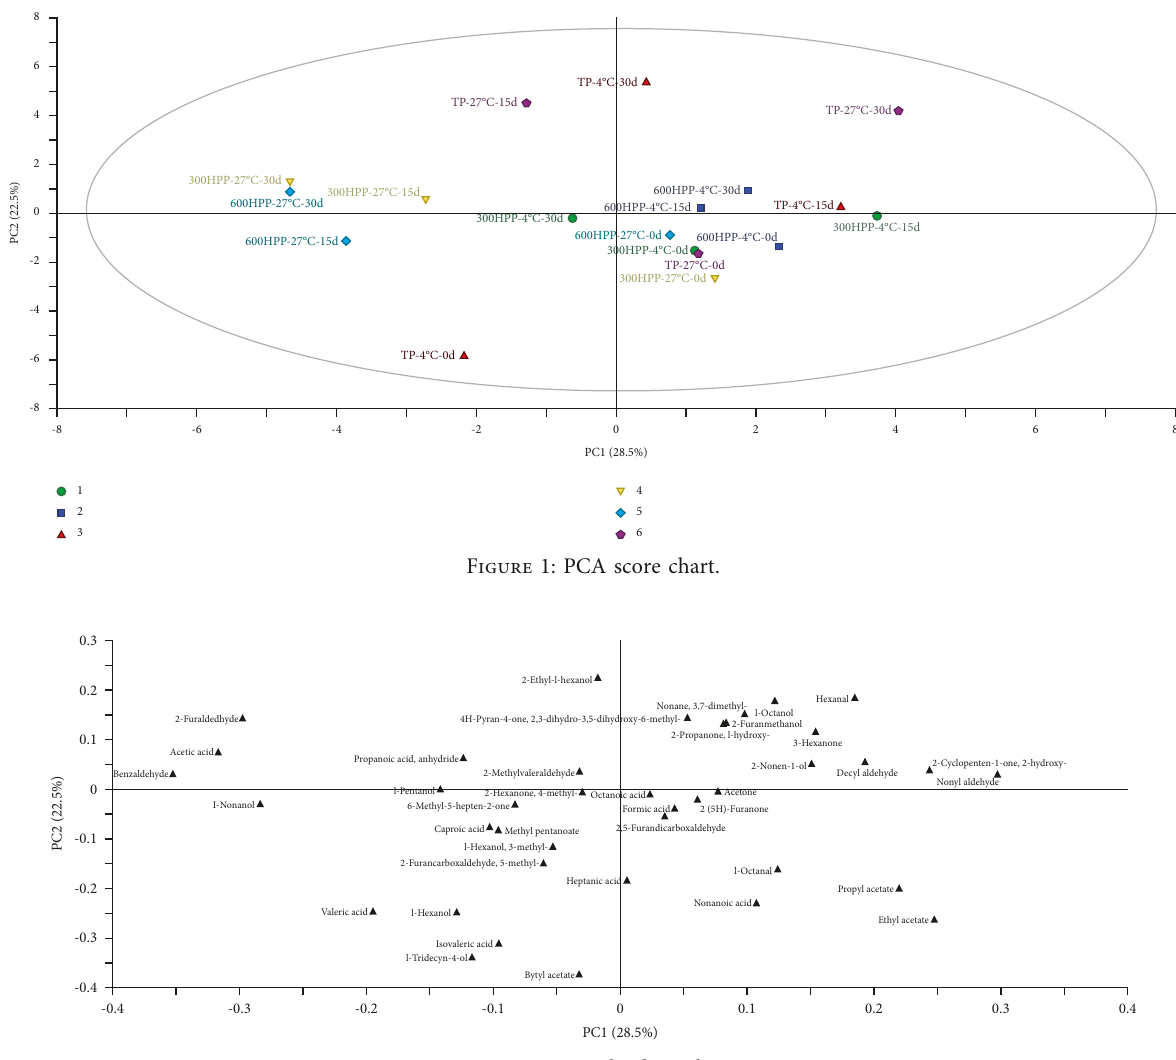
Figure 2: PCA loading plot.